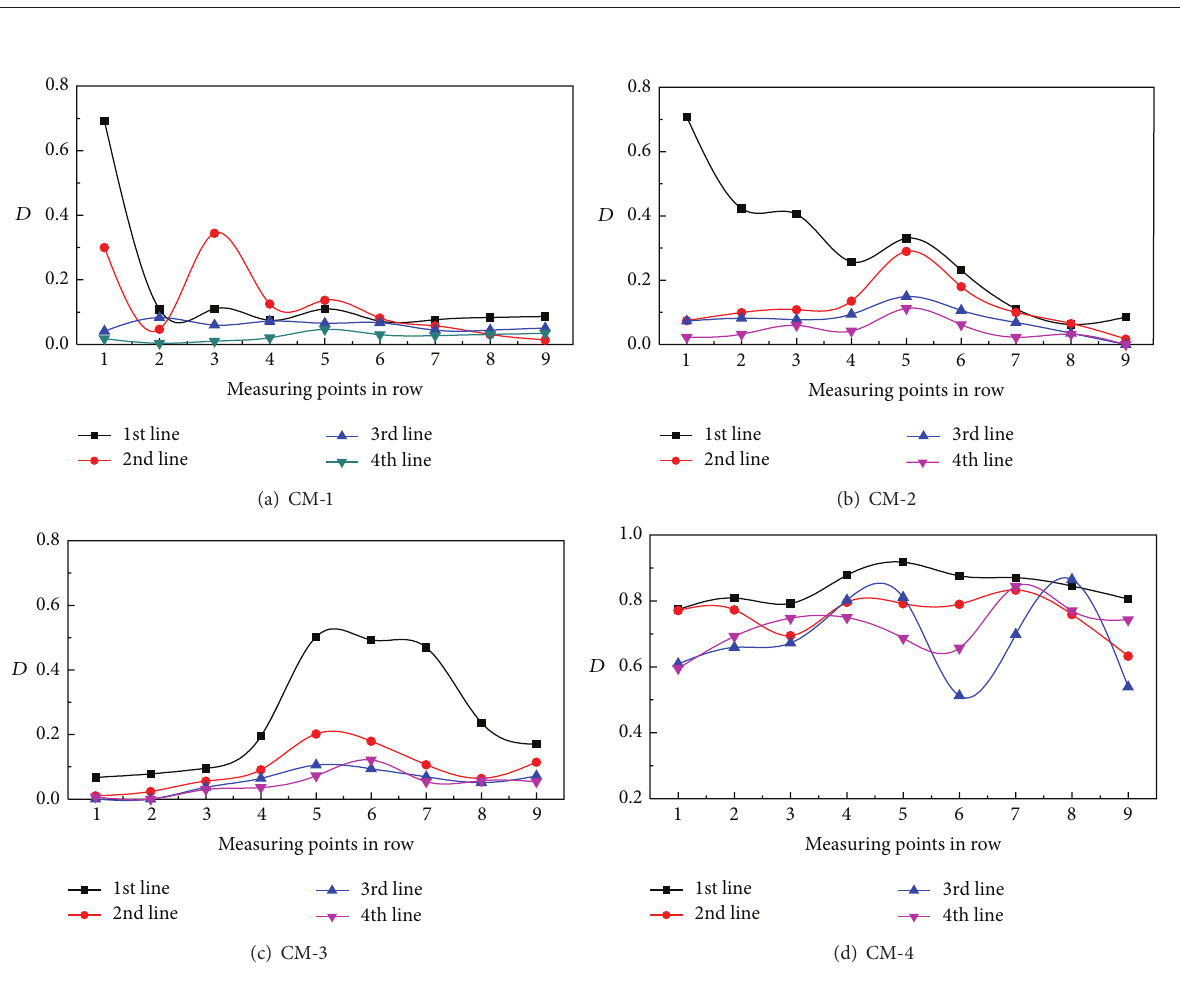
Figure 3: Curve of blast-induced damage factor 𝐷